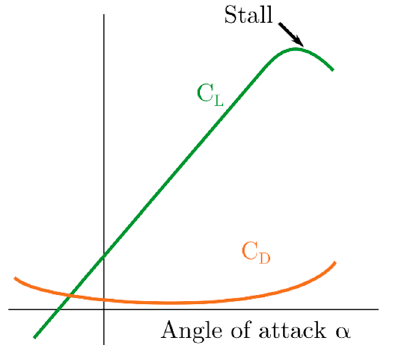
Figure 1. Typical evolution of lift and drag coefficients as a function of the angle of attack.